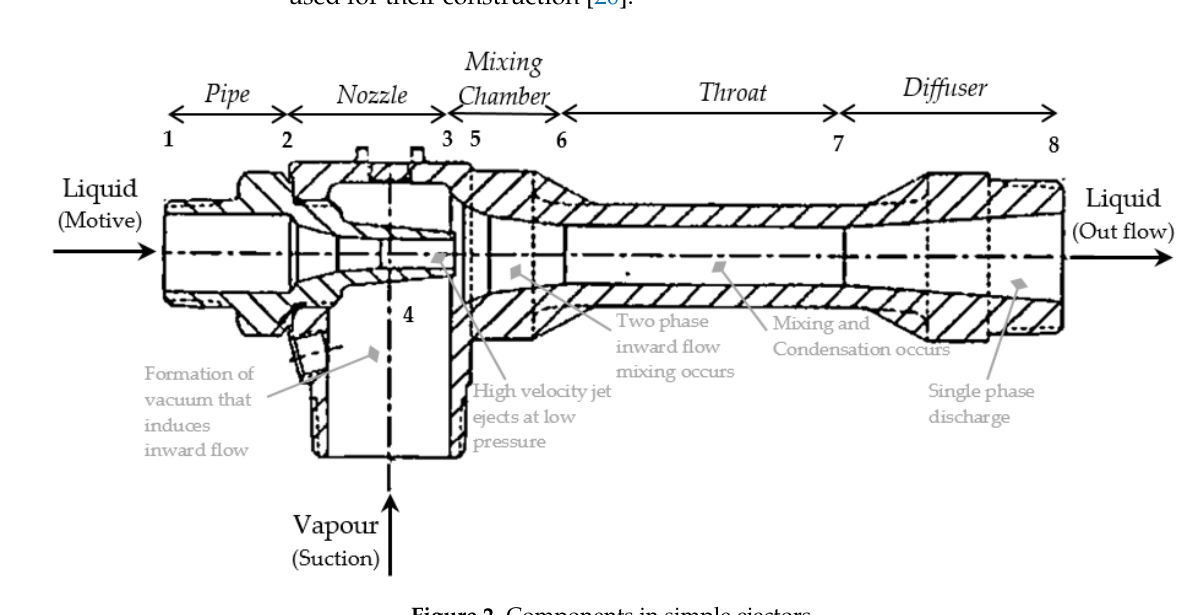
Figure 2. Components in simple ejectors.